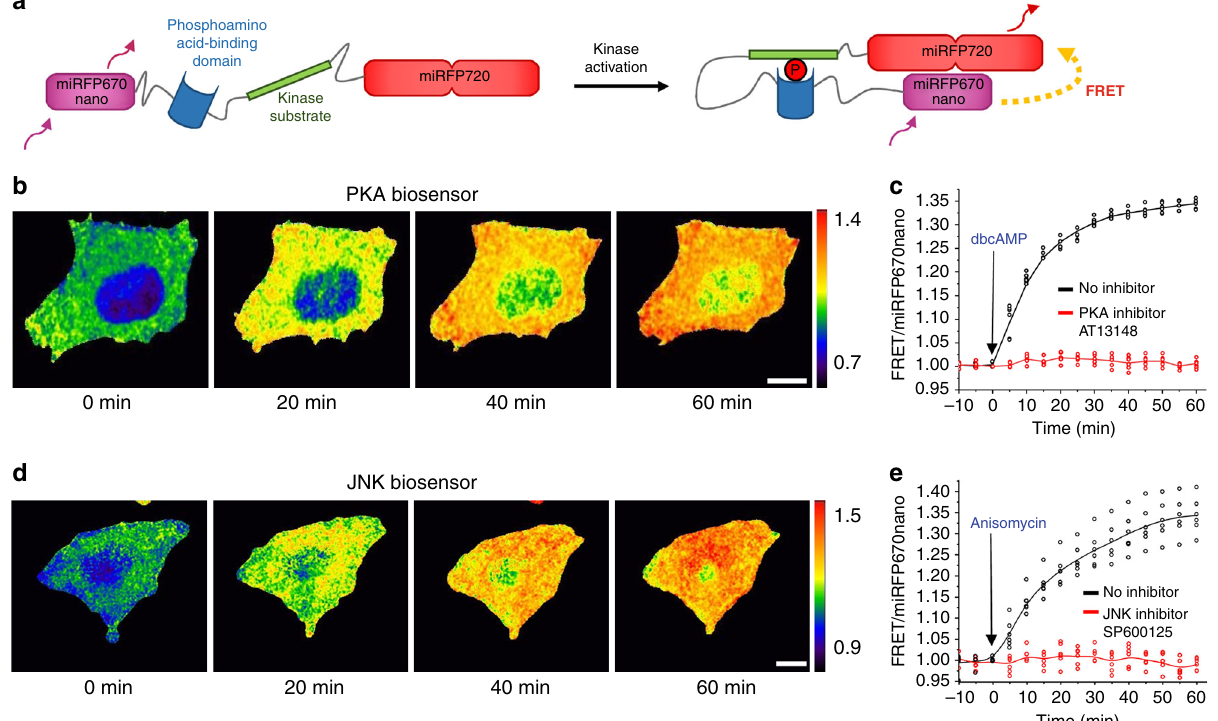
Fig. 5 NIR biosensors for detection of PKA and JNK kinase activities. a Schematic representation of miRFP670nano-miRFP720-based NIR FRET